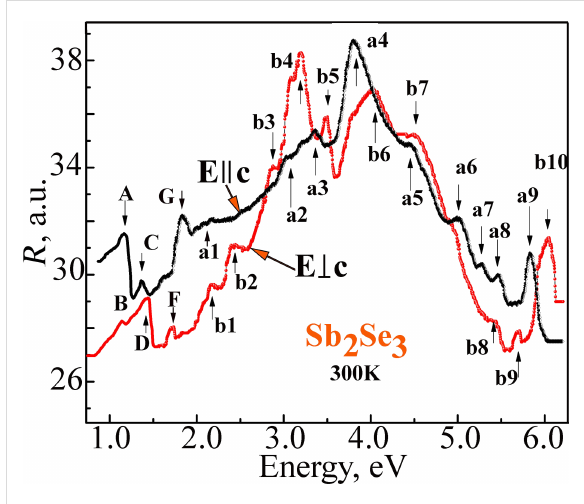
Figure 8: The reflection spectra of the Sb 2 Se 3 crystals measured at room temperature under Е || с and Е ⟂с polarization